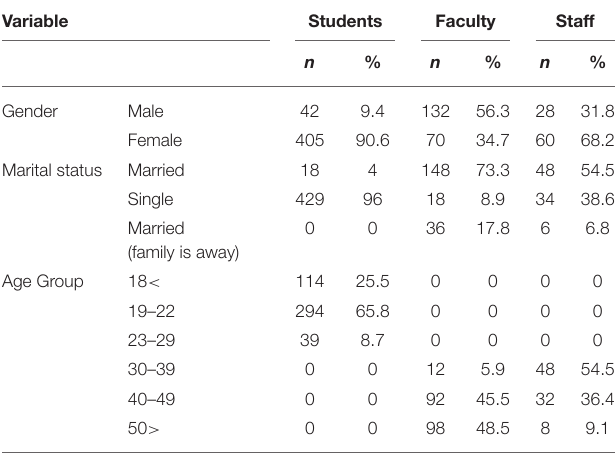
TABLE 1 | Description of the demographic characteristics of the study sample. Variable